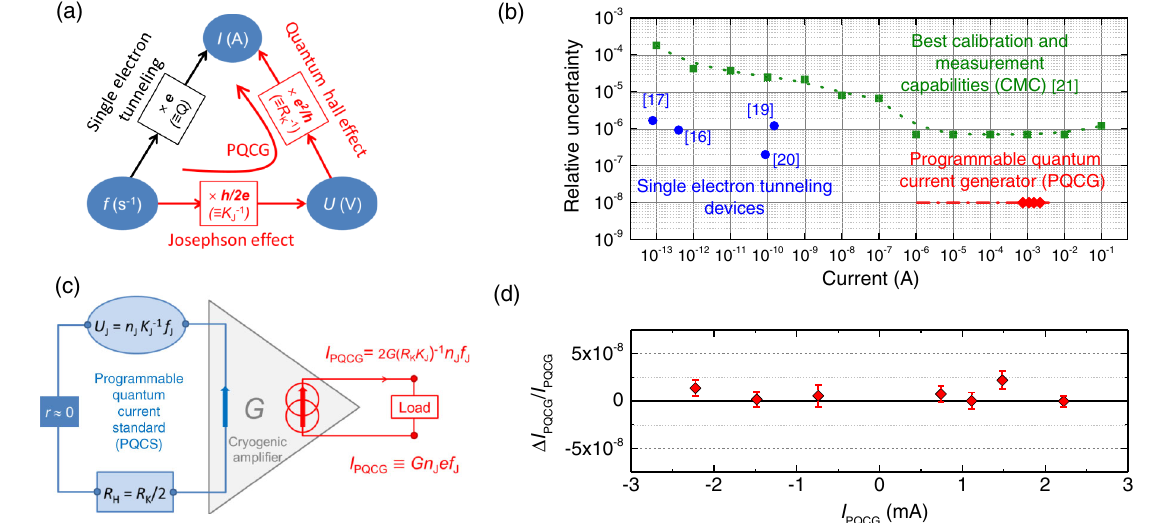
FIG. 1. Practical realization of the ampere from quantum electrical effects. (a) Illustration of the two ways to generate a current from the frequency f ð s − 1 Þ and the elementary charge e , expressed in amperes in the future SI. The current can be generated either using single-electron tunneling devices or the combination of the Josephson effect and the quantum Hall effect. Quantum effects involve fundamental constants whose uncertainties in the present SI will be reduced to zero in the future SI. (b) Comparison of the relative uncertainty of the current generated by the PQCG in the milliampere range (red diamonds) to state-of-the-art current measurements or generation. These high-accuracy results include the best calibration and measurement capabilities (CMCs) [green squares: from 10 − 13 up to 10 − 11 A, by charging a capacitor (Physikalisch-Technische Bundesanstalt), and from 10 − 10 up to 10 − 1 A, by applying Ohm ’ s law (Laboratoire national de métrologie et d ’ essais)] [21] and the main SET-device results mentioned in the text (blue dots). The red dashed- dotted line shows the estimated relative uncertainties of the current generated by the PQCG from 1 μ A up to 10 mA. (c) Principle of the =I PQCG. (d) Relative deviation Δ I of the measured current from the quantized value in the milliampere range. Error bars are PQCG PQCG combined standard uncertainties (1 s.d.). No significant relative discrepancies can be observed within an uncertainty of 10 − 8